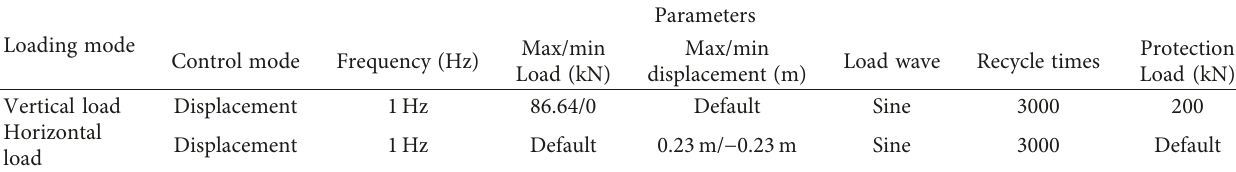
Figure 5: The making process of specimens. (a) Mixing. (b) Filling. (c) Leveling. (d) Tamping and mud extracting. (e) Rendering. (f) Finishing. Table 2: Experiment relevant